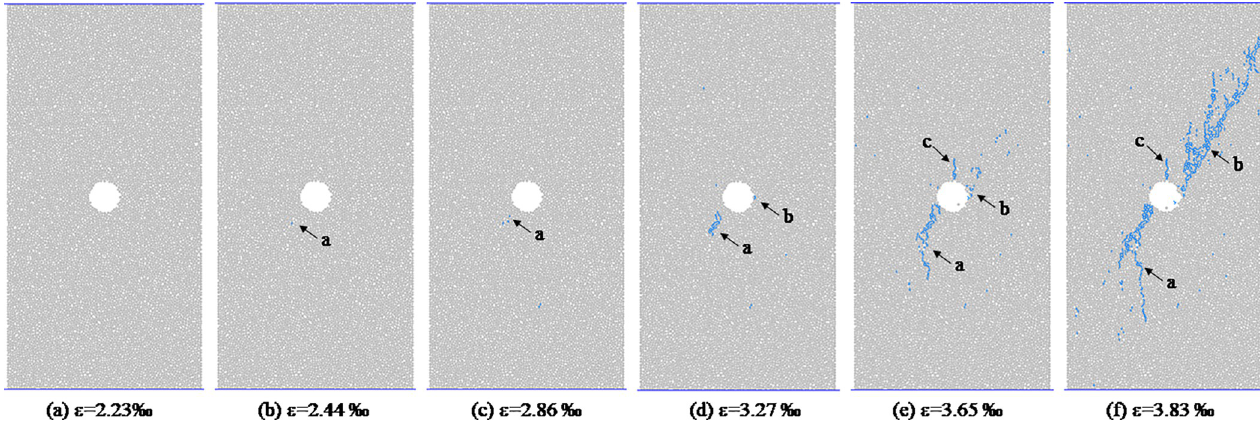
Fig 12. Meso-damage process of coal and rock with circle hole